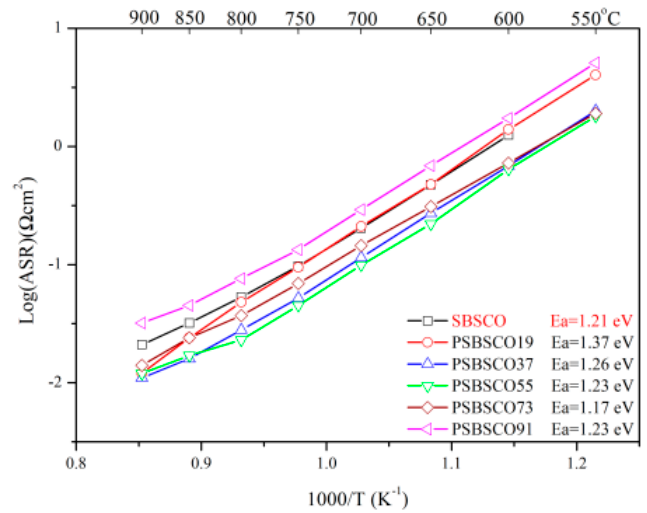
Figure 3. ASR of the Pr and Sm contained samples with different x values [5].